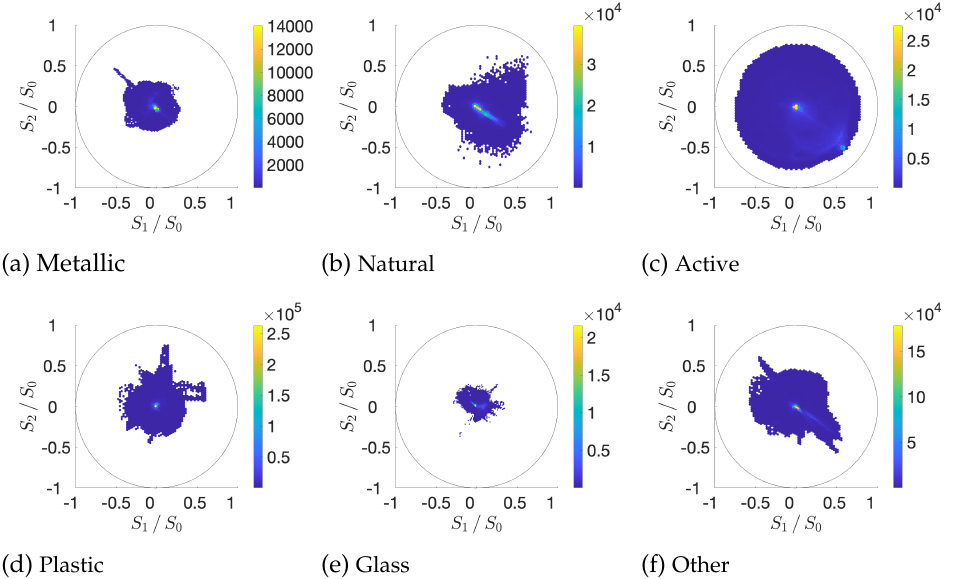
Figure 4. Scatter plots of polarization data for material clusters for the green channel ( c = G ), approximating the luminance. We also observe similar behaviors on the red and blue channel. Each plot represents the plane of the equator of the Poincaré sphere (latitude is zero for linear polarization). The Stokes component values [25] S 1 = ρ 0, G − ρ 90, G and S 2 = ρ 45, G − ρ 135, G are normalized with respect to the total irradiance S 0 = ρ 0, G + ρ 90, G . The center of the circle represents unpolarized data, whereas the unit circle represents fully polarized data. The distance from the center is the degree √ S 2 1 + S 2 2 of linear polarization DOLP = , and the angle with respect to the origin is 2 β , so that the S 0 orthogonal polarizations are shown to be diametrically